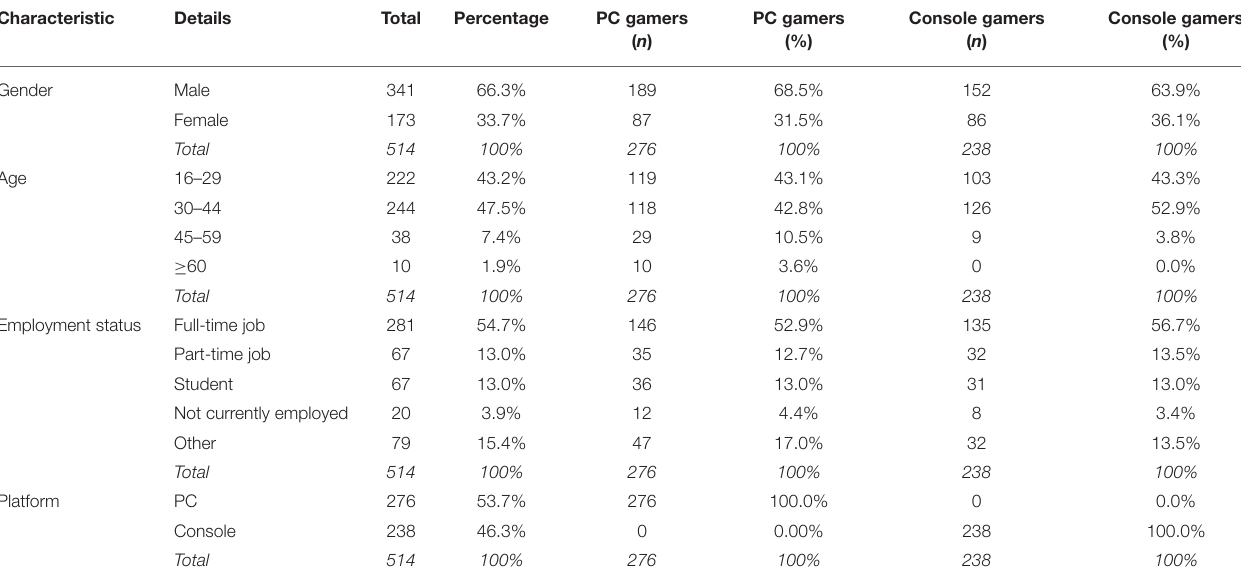
TABLE 2 | Demographic